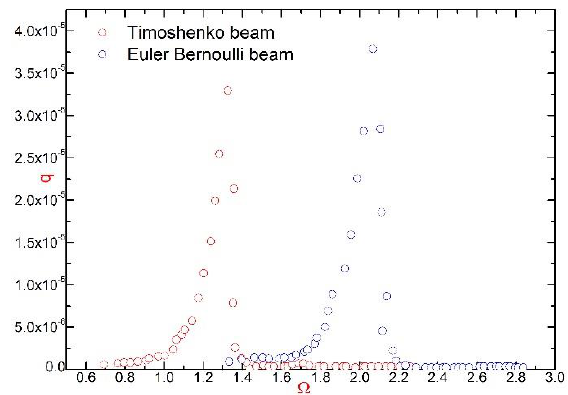
Figure 11. Influence of transvese direction (b) in rotation direction.